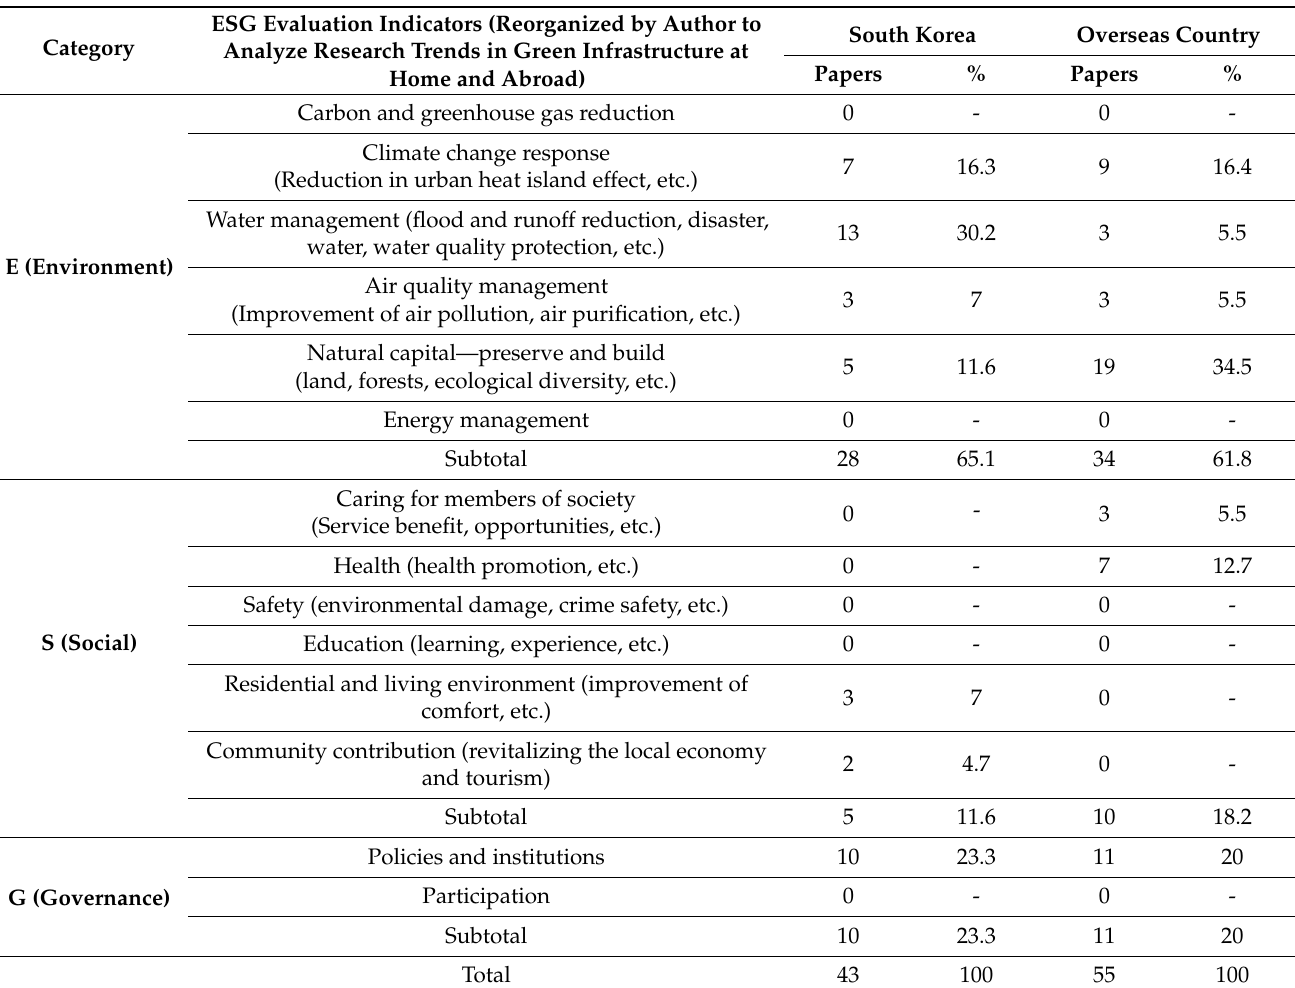
Table 4. Status of publication of domestic and international green infrastructure research according to ESG evaluation